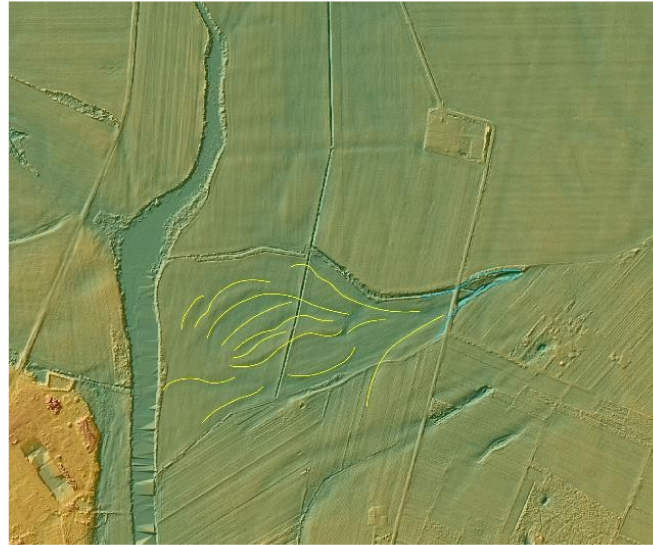
Figure 8. Zoom B: an example of crevasse (blue) and crevasse splay (yellow) identified in the modeling